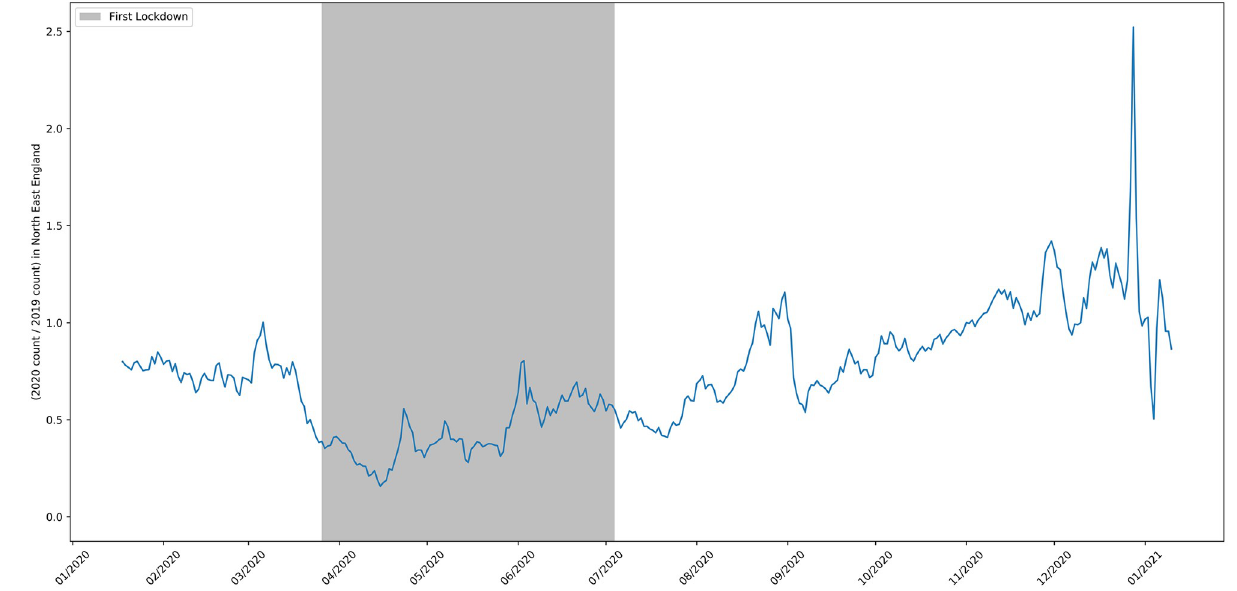
Fig 12. The 2020 to 2019 ratio of job adverts in the North West.